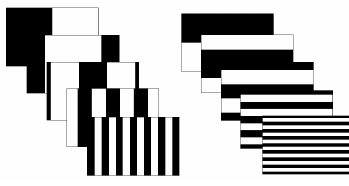
Figure 6. Both parts of the pattern ( image credits [18]) (here the markers corners) and their 3D coordinates can be